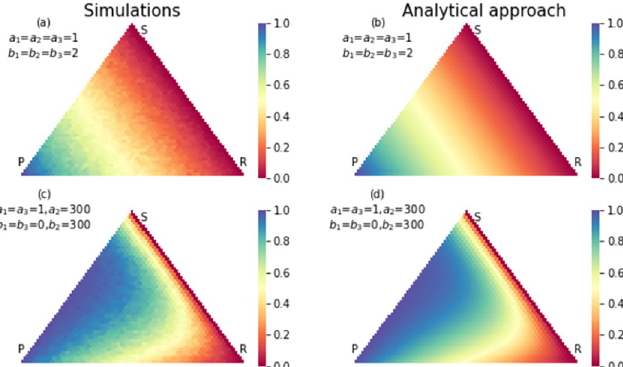
Fig 2. The simulation (a) and analytical (b) results for fixation probability of strategy paper in an RSP game with neutral selection. The size of population is 50. The states close to absorption state P = N , S = 0, R = 0 have a higher chance of absorbing in this absorption state. In (c) and (d) same results were shown with a strong selection in favor of paper strategy and detriment of rock strategy. Compared to the neutral case, many states have a higher chance to absorb to paper